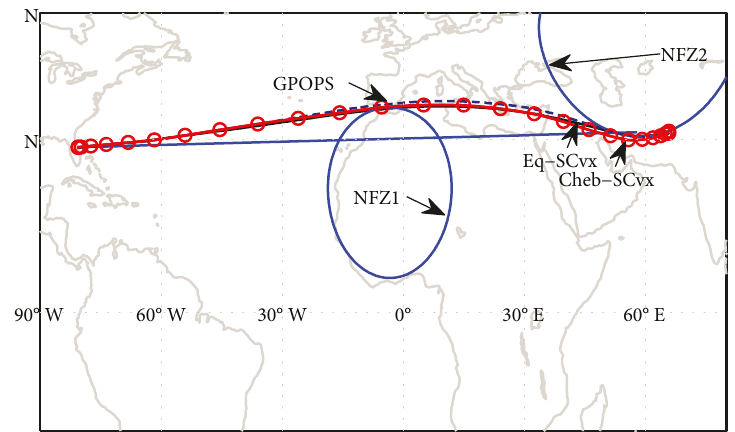
Figure 2: Ground tracks of